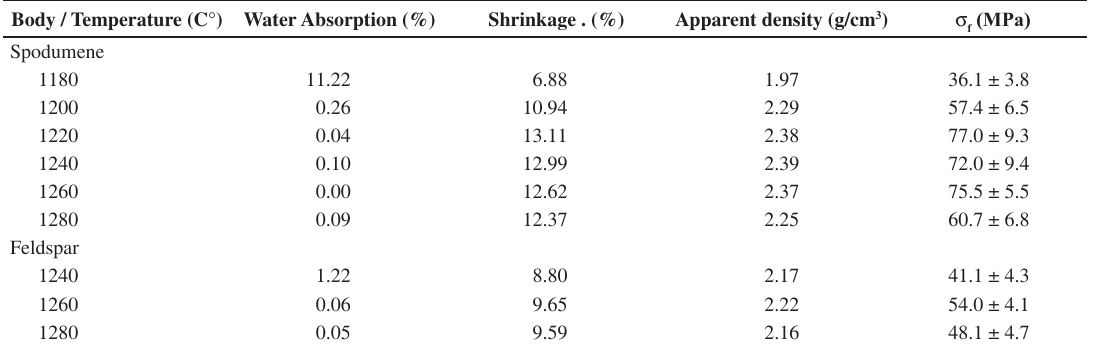
Table 4. Technical characterization of fired bodies.